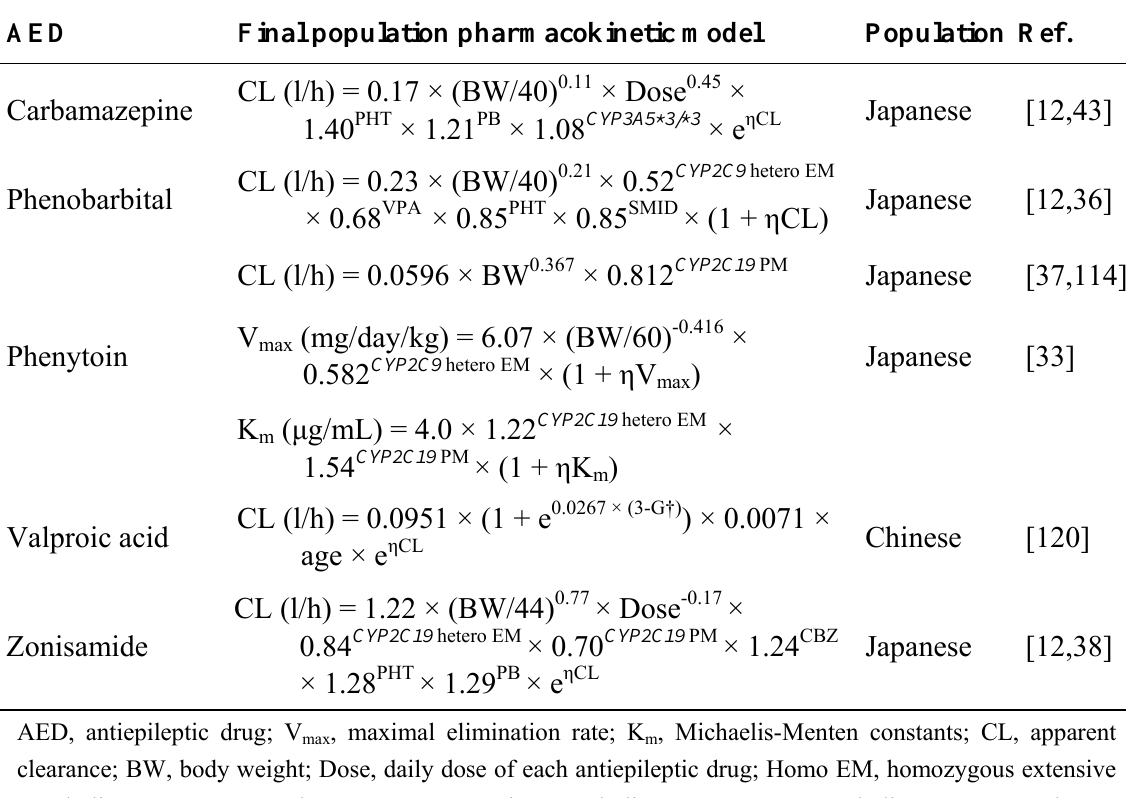
Table 2. The population pharmacokinetic model of antiepileptic drugs incorporating the drug-metabolizing enzyme